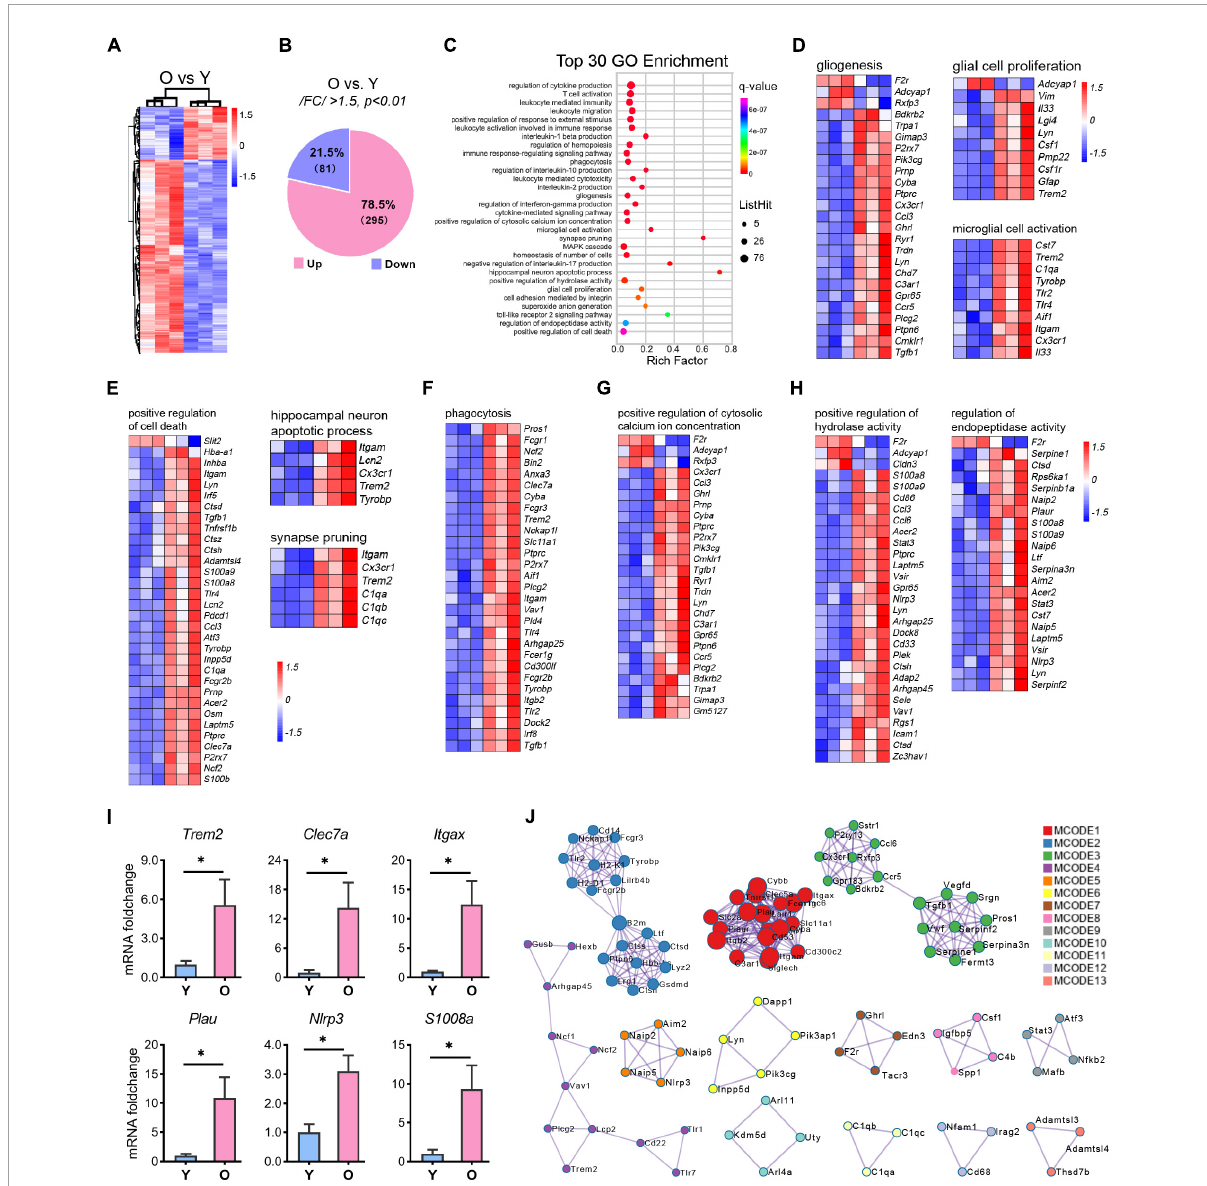
FIGURE5 RNA-seq analysis of the differential expressional genes enriched in aging. (A,B) Hierarchical heatmap analysis [ (A) , n = 3 per group] and pie graph of the up-and down-regulated genes composition (B) of the differentially expressed genes (DEGs) as determined by the selection criteria: | FC| > 1.5 and p < 0.01. (C) Top 30 GO terms enriched by the MetaScape tool. The diameter of the solid circle denotes the number of DEGs enriched and the color showing the p -value in the corresponding pathway. (D–H) Gene cluster enriched in gliogenesis, glia cell proliferation, and microglia activation (D) ; positive regulation of cell death, hippocampus neuron death, and synapse pruning (E) ; phagocytosis (F) ; positive regulation of cytosolic calcium ion concentration (G) ; and regulation of endopeptidase activity and positive regulation of hydrolase activity (H) . (I) qRT-PCR analysis of selected genes related to microglial activation and neuroinflammation. Data are calculated as the mRNA foldchange of the young group and represent the means ± SEM. Unpaired Student’s t -test, n = 3–6 per group ∗ p < 0.05. (J) The Hub genes clustering by the protein-protein interaction network as determined by the MCODE tool of